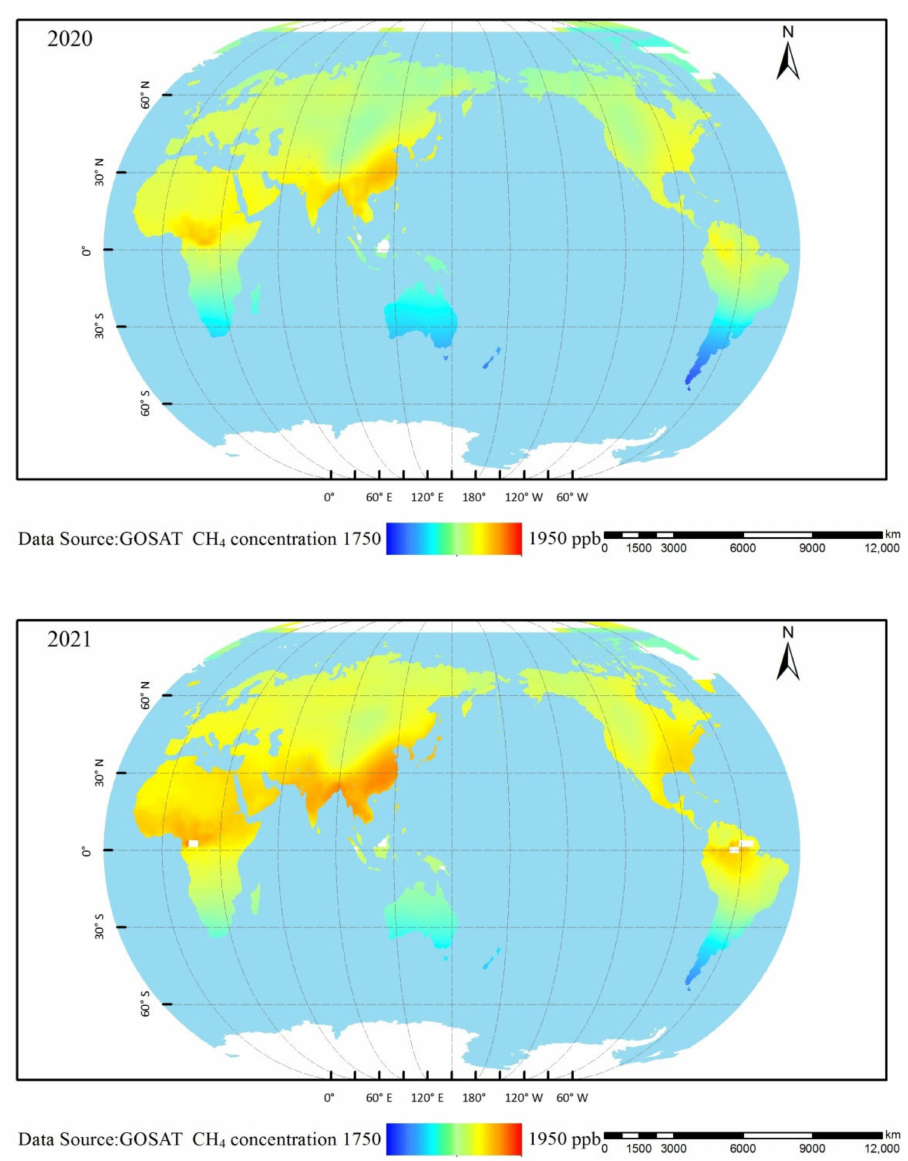
Figure 5. Map of global annual CH 4 concentrations in 2020 and